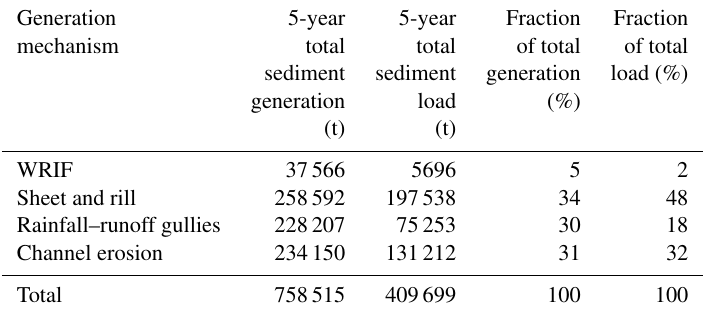
Table 3. The 5-year total sediment generation and load rates (by process), fraction of total generation, and fraction of total load for the Los Laureles